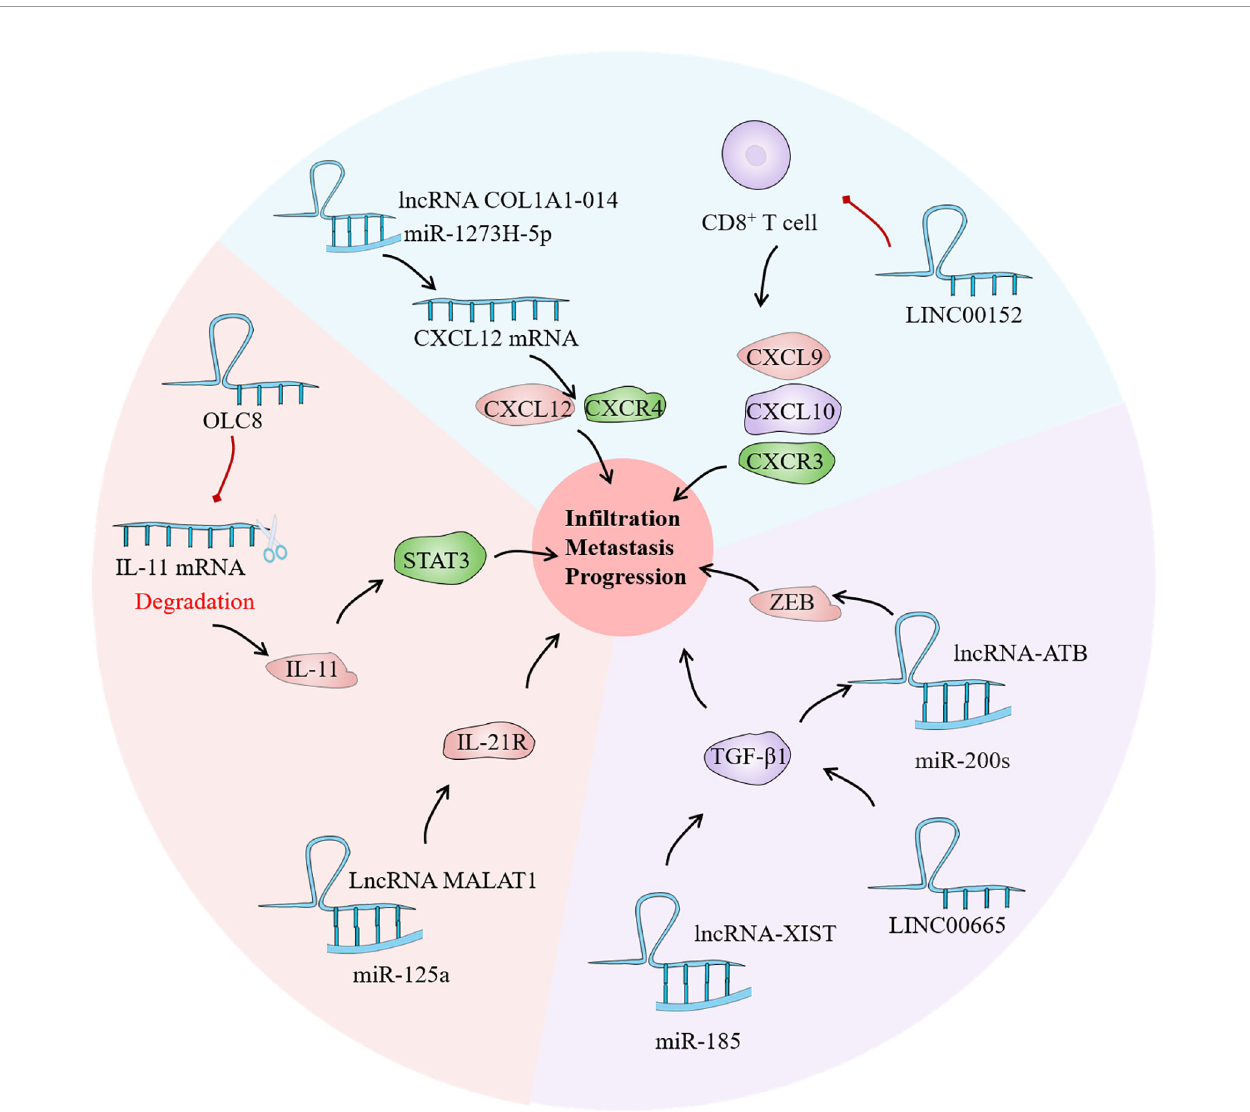
FIGURE 5 | As a bridge of information exchange between gastric cancer (GC) immune microenvironment (TIME) and tumor cells, cytokines play an important role in the evolution of GC. Current studies have con fi rmed that lncRNA has regulatory effects on the interleukin (IL) family, tumor growth factor (TGF) and chemokines in the GC TIME, which may become a potential tumor therapeutic